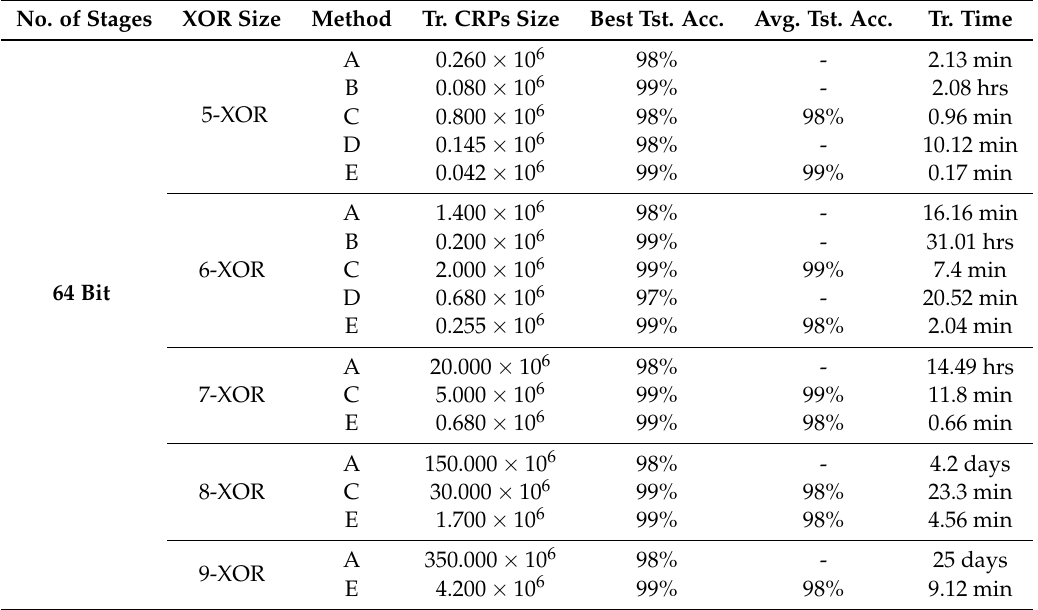
Table 3. Prediction rate and timing of our attacking method and other methods using simulated